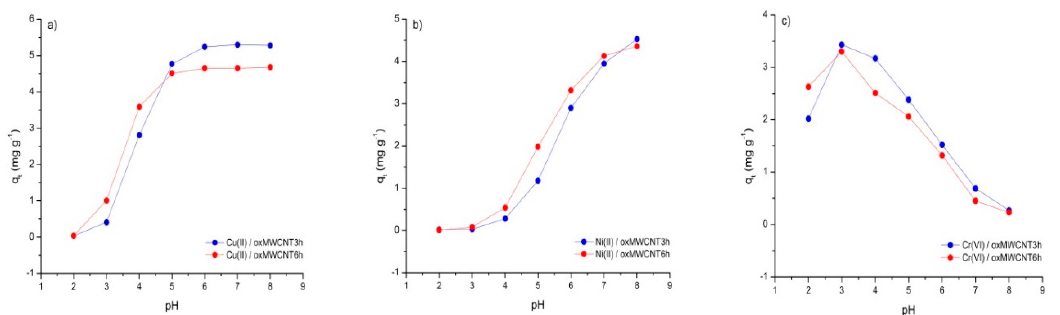
Figure 7. Adsorption of ( a ) Cu(II), ( b ) Ni(II) and ( c ) Cr(VI) on oxMWCNT3h and oxMWCNT6h as a function of pH ( m = 5 mg, V = 30 mL (0.1 M NaNO 3 ), C 0 = 1 mg L − 1 , pH = 2–8 ± 0.1, t = 24 h (Cu(II) and Ni(II)) and 96 h (Cr(VI)), agitation speed = 180 rpm, T = 298 ± 2 K).